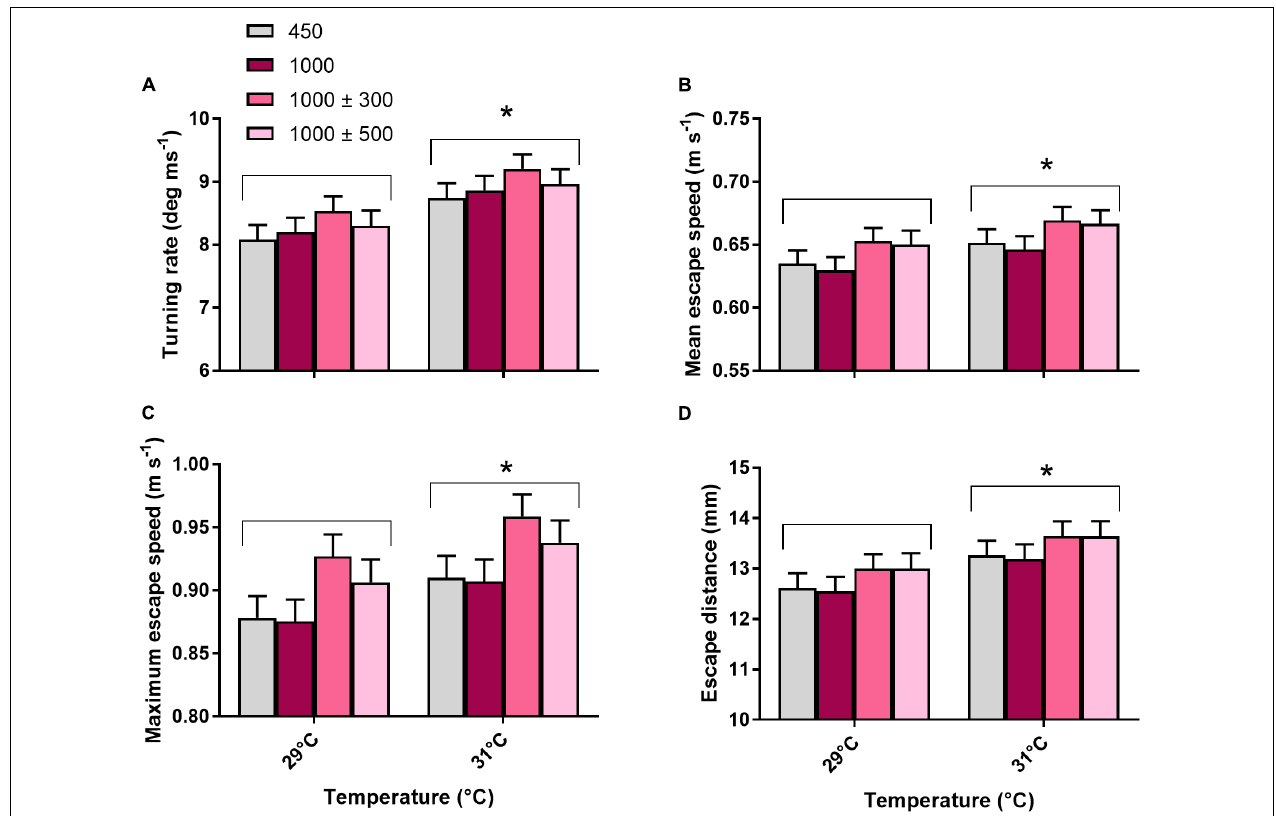
FIGURE 6 | Effects of elevated CO 2 and temperature on locomotor fast start traits of juvenile A. polyacanthus . (A) Turning rate. (B) Mean escape speed. (C) Maximum escape speed. (D) Escape distance. Bars represent means ± SE. ∗ Indicates a significant difference between temperature treatments ( P <